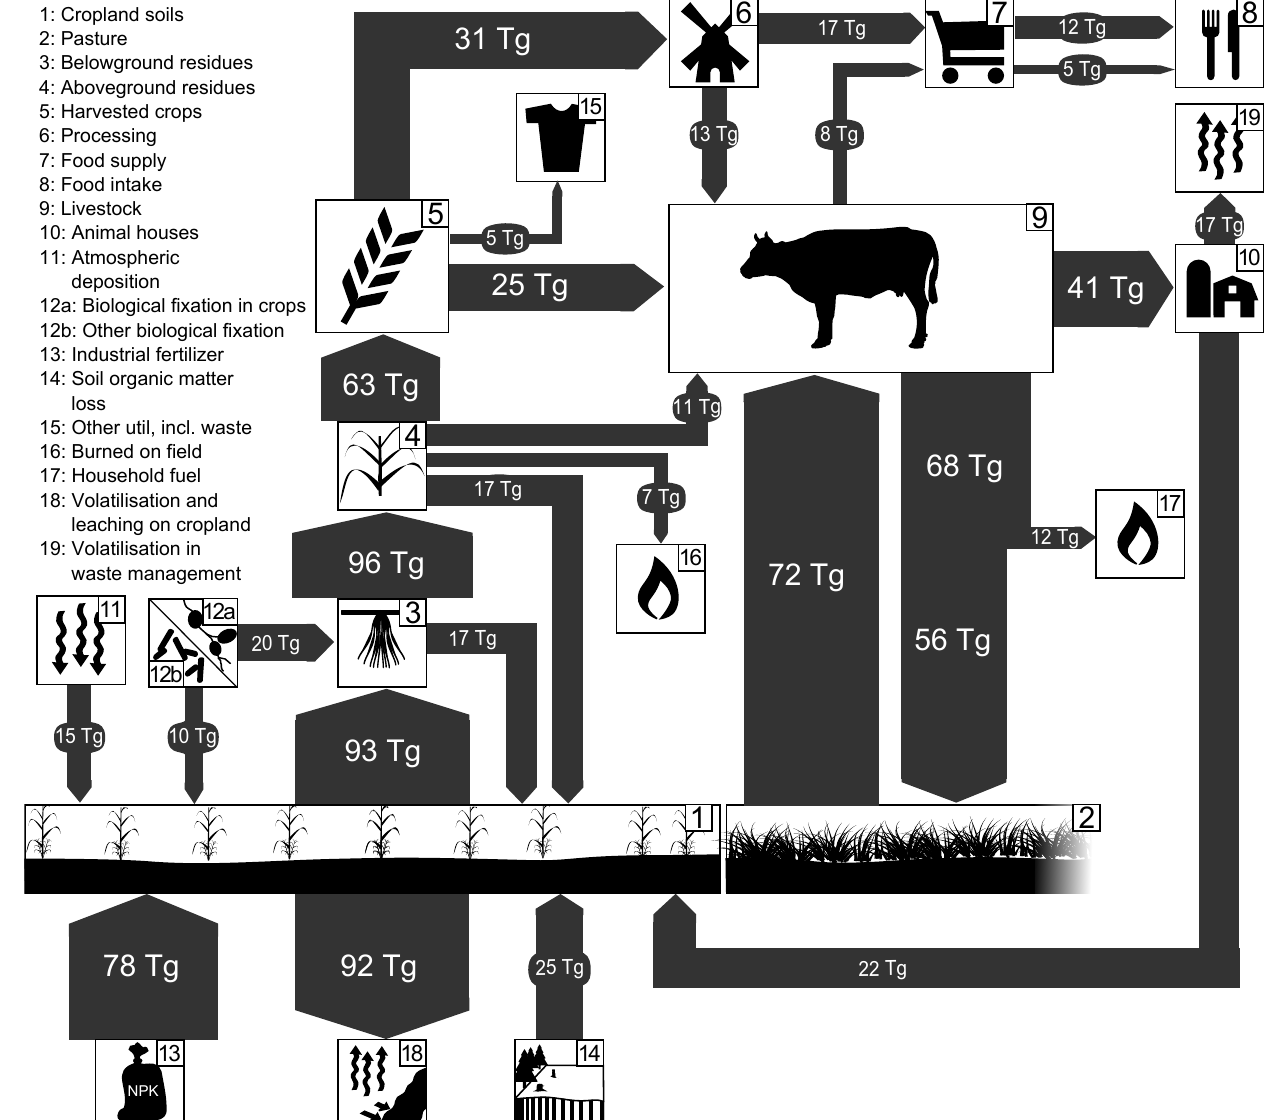
Fig. 2. Agricultural N r cycle in TgN r in the year 1995. Flows below 5TgN r are not depicted. No estimates were made for N r inputs to pasture soils by atmospheric deposition and biological